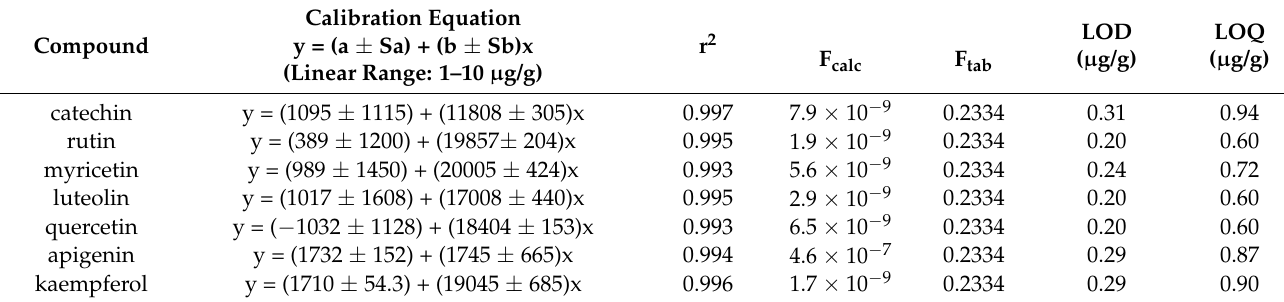
Table 1. HPLC-DAD method analytical parameters.